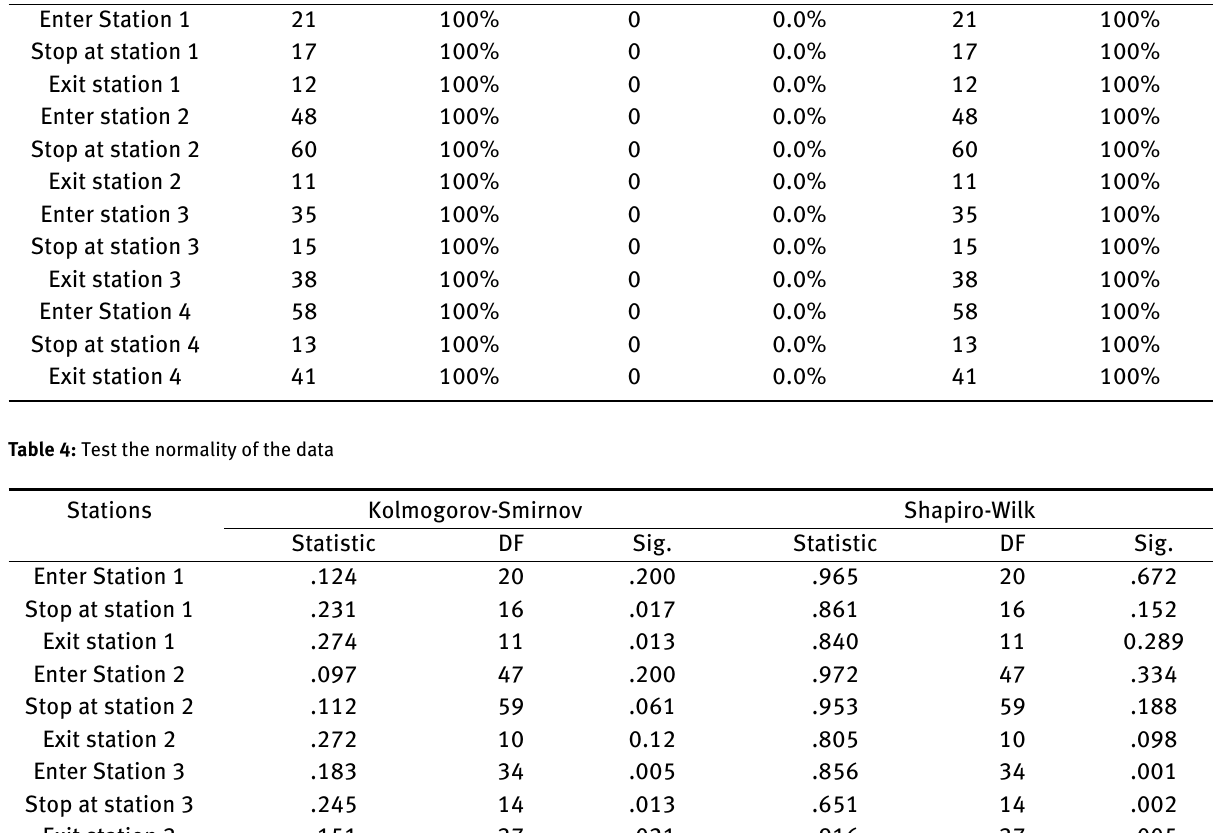
Table 3: Abundance and cumulative frequency Stations